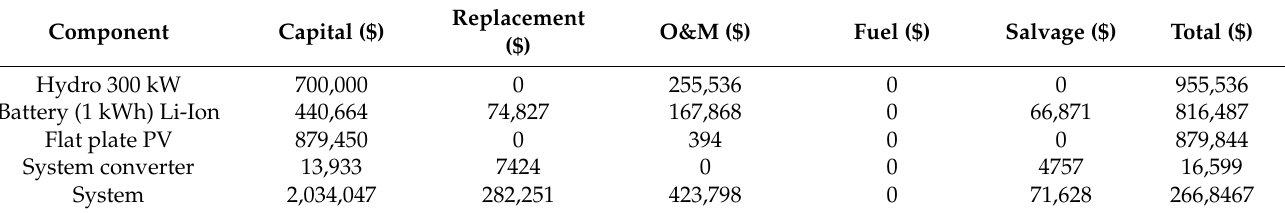
Table 10. System architectural costs for proposed hybrid option 3.